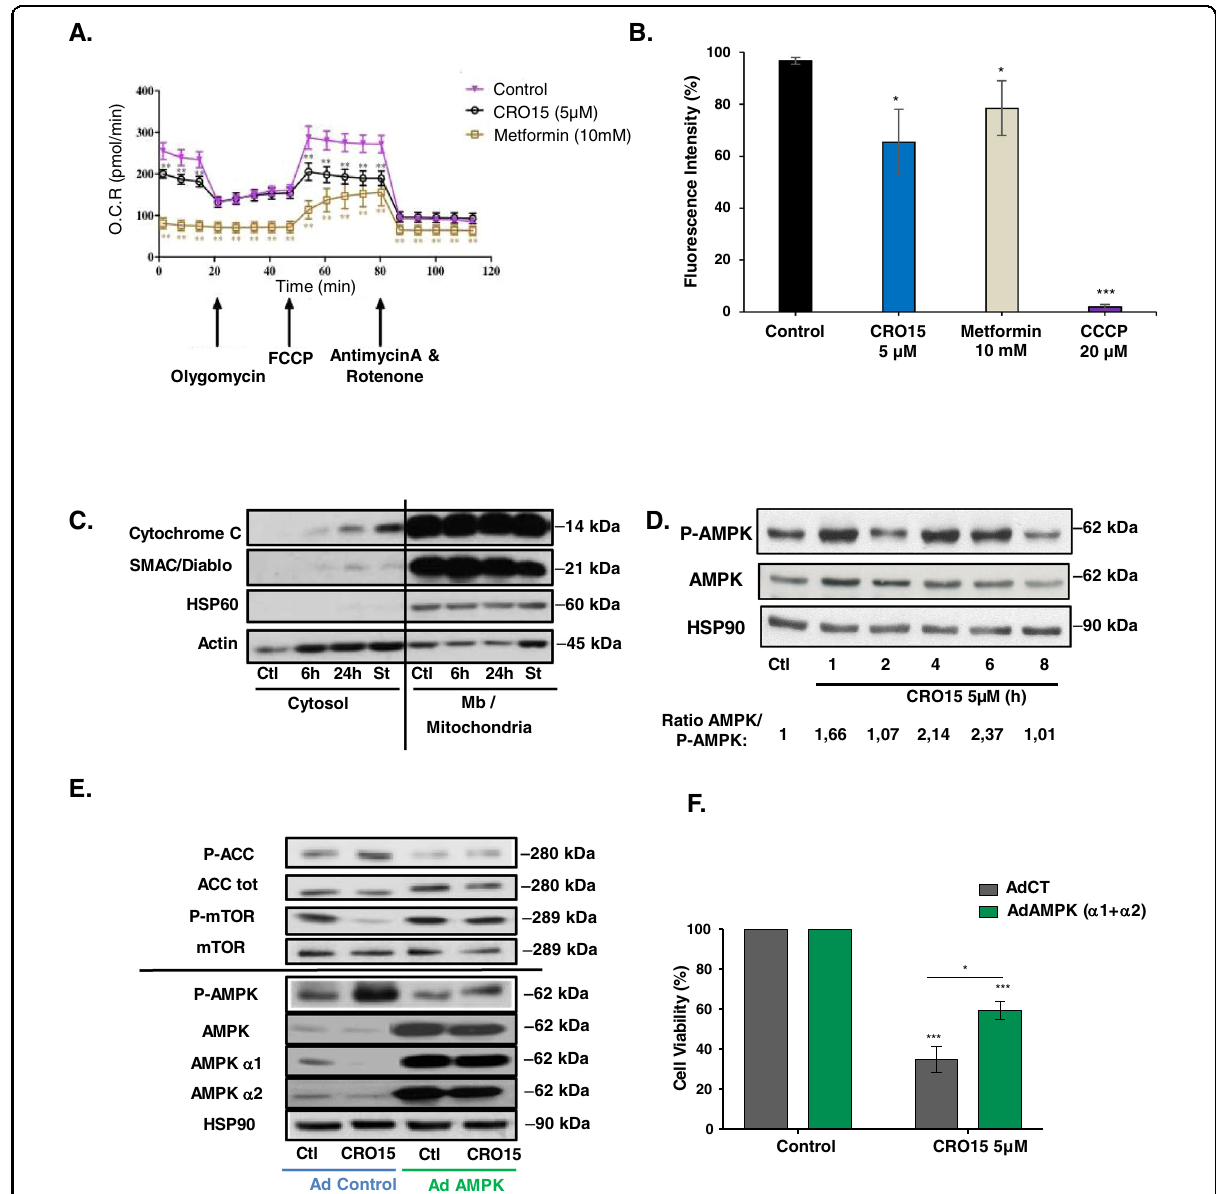
Fig. 2 CRO15 induces a mitochondrial disorder and activates AMPK pathway. A Measurement of mitochondrial function in A375 melanoma cells with a Seahorse XF Cell Mito stress test after 6 h of treatment with 5 μ M CRO15, 10 mM metformin or DMSO used as control. At 20 min, cells are treated with oligomycin, an inhibitor of complex V of respiratory chain; at 50 min, with FCCP, which disrupts the mitochondrial membrane potential; and at 80 min, with Rotenone and antimycin A, inhibitors of complex I and III, respectively. B A375 cells were treated with 5 μ M CRO15 (6H), 10 mM metformin (6H) for or 20 μ M CCCP (20 min). Measurement of mitochondrial potential membrane was performed by fl ow cytometry with a TMRE probe. C Lysates from A375 melanoma cells exposed for the indicated durations to CRO15 were analyzed by western blotting using the indicated antibodies after cell fractionation. One representative experiment of three is shown. D Lysates from A375 cells treated with 5 μ M CRO15 for the indicated durations were analyzed by western blotting using the indicated antibodies. One representative experiment of three is shown. E Lysates form A375 cells transduced with dominant negative AMPK subunits α 1 and α 2 for 24 h and treated with 5 μ M CRO15 were analyzed by western blotting using the indicated antibodies. One representative experiment of three is shown. F Quanti fi cation of cell viability from E using trypan blue exclusion method. Results are expressed as percentages of DMSO control and data given as the means ± SEM of three independent experiments performed in triplicate. * p < 0.05; ** p < 0.01; *** p <